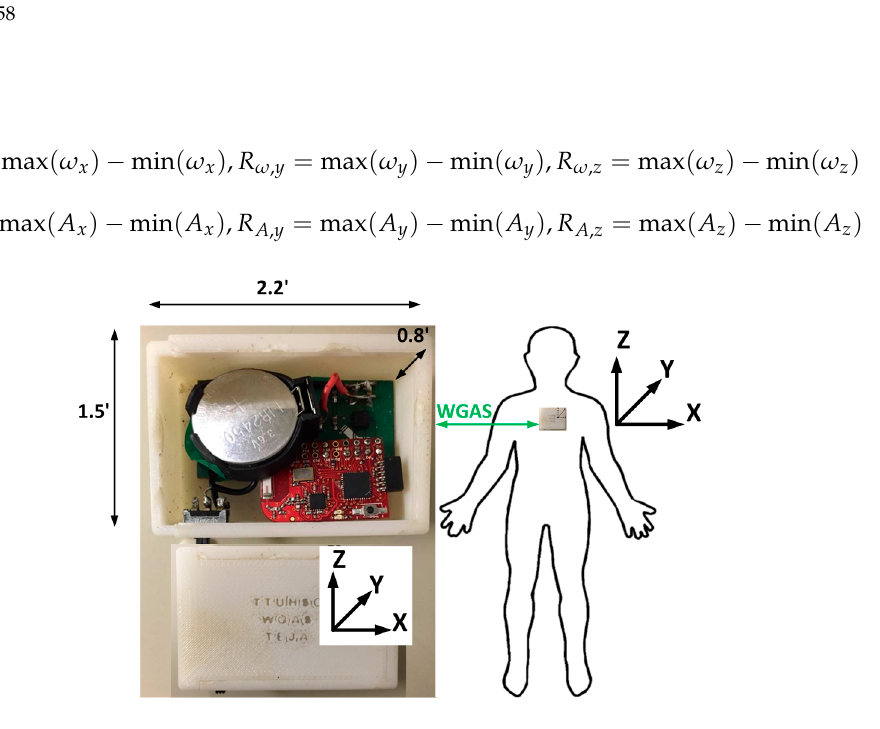
Figure 1. Physical structure and dimension of our custom-designed wireless gait analysis sensor (WGAS) hardware and the orientation placed during tests at T4 (back).